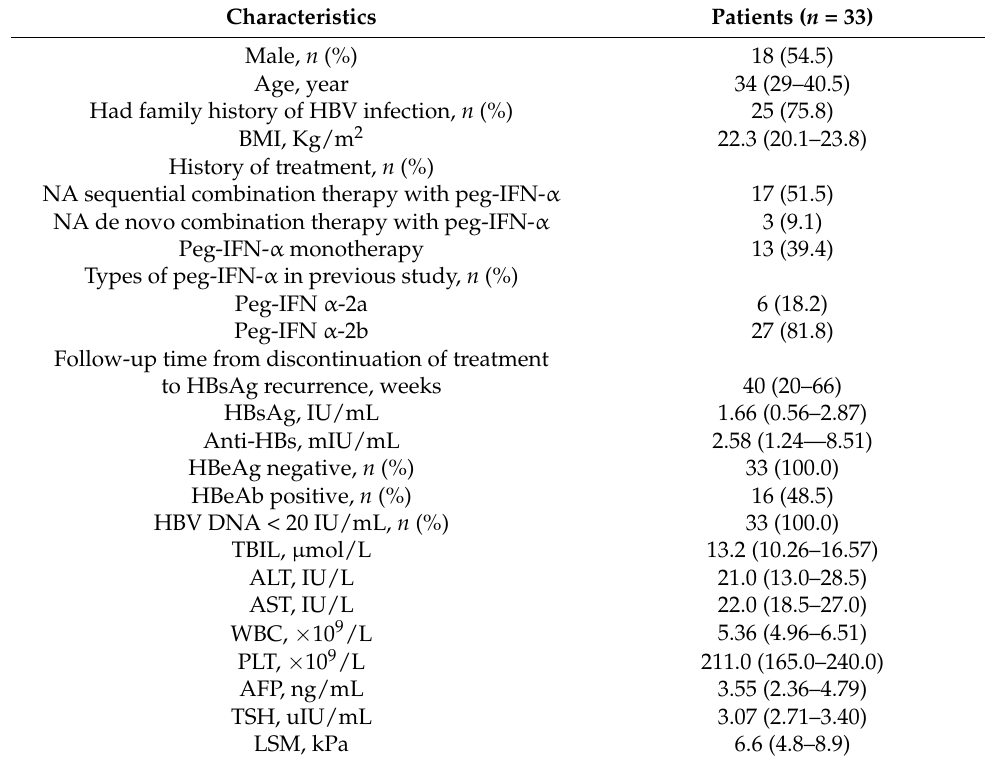
Table 1. Baseline demographic and clinical characteristics of the study